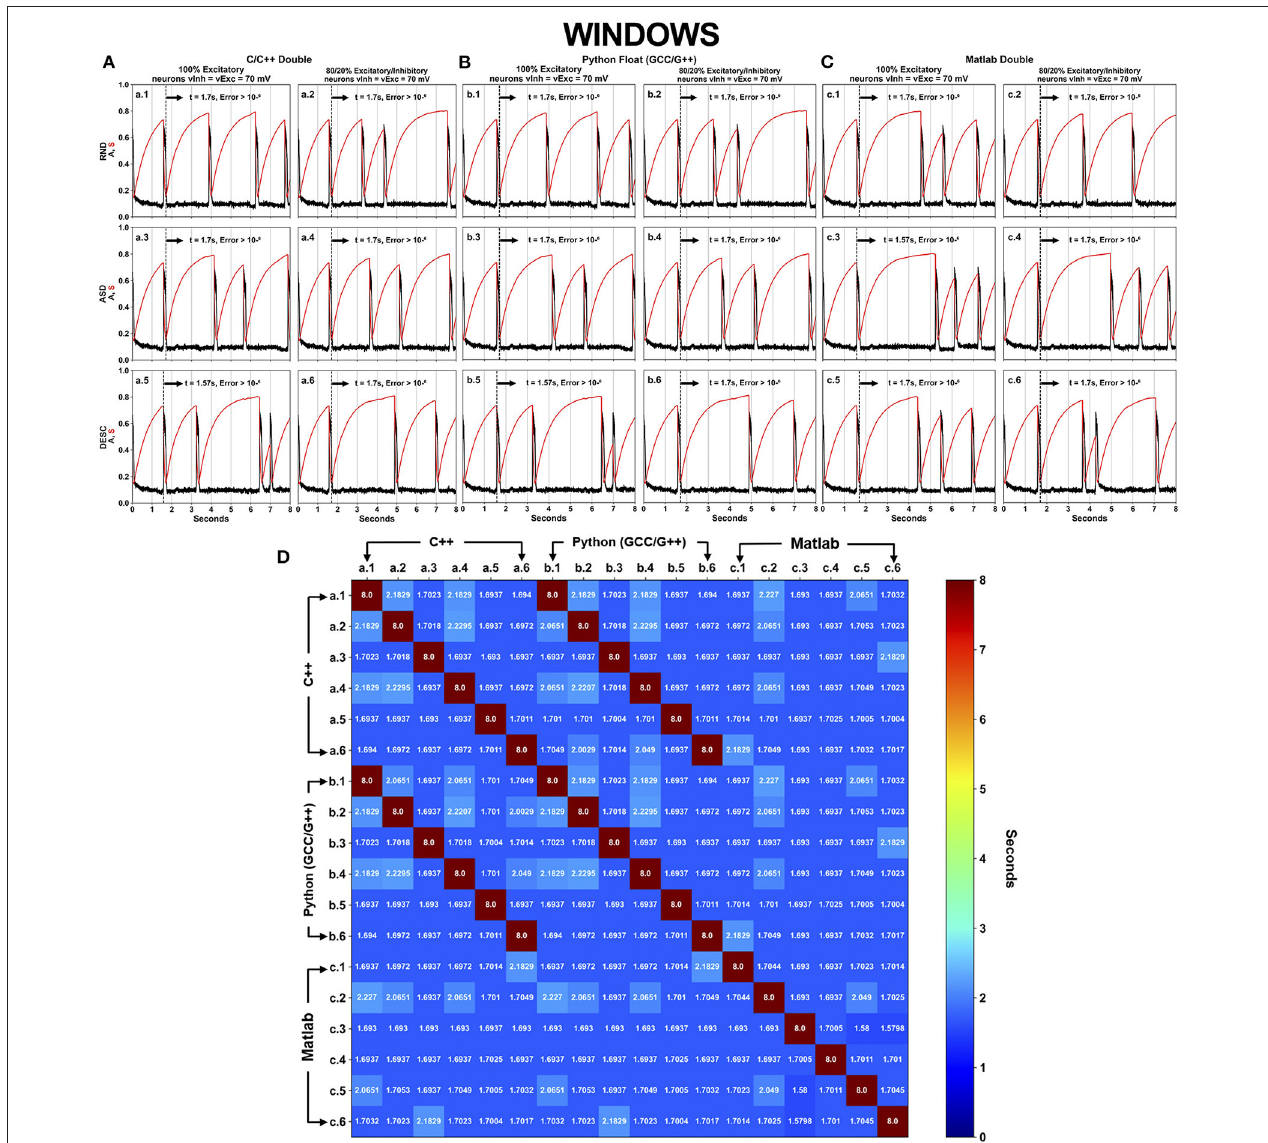
FIGURE 4 | Neural activity results simulated using DFPP on Windows, which did not replicate the HFPP results. Each panel (A–C) has six (6–SPLT × SORT − 2 × 3) scenarios explained in Figure 1 for C/C ++ , Python GCC/G ++ and Matlab, respectively. The spontaneous network activity < A > and the network synaptic efficacy < S > are represented by the black and red curve profiles, respectively. The black vertical dashed line in each graph shows the time when the absolute error is > 10 − 6 in comparison with the simulation that used HFPP ( Figure 3 ). The last panel (D) displays a square matrix with an all-to-all comparison of these 18 scenarios based on the absolute error among simulations. Each cell represents the first moment in time (seconds) when the absolute error reached a value > 10 − 6 . Only the corresponding graphs of C/C ++ (A.n panel) and Python GCC/G ++ (B.n panel) replicated the results of < A > and < S > values. Simulations implemented with Matlab did not replicate the values as C/C ++ and